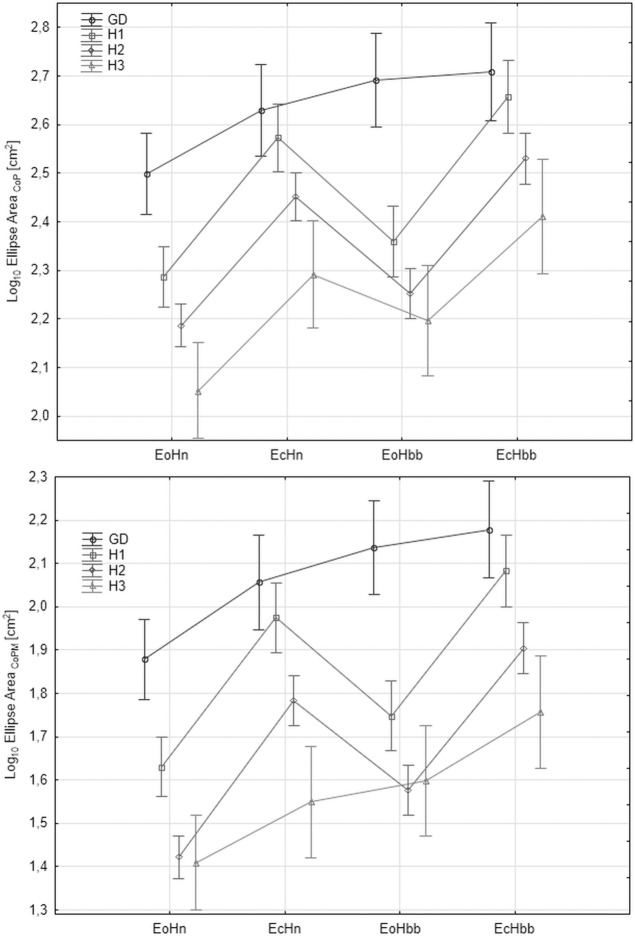
The mean values of LECoP = log10(ECoP90) (upper) and LECoPM = log10(EACoPM90) (bottom) in the subsequent patients and registration condition groups.